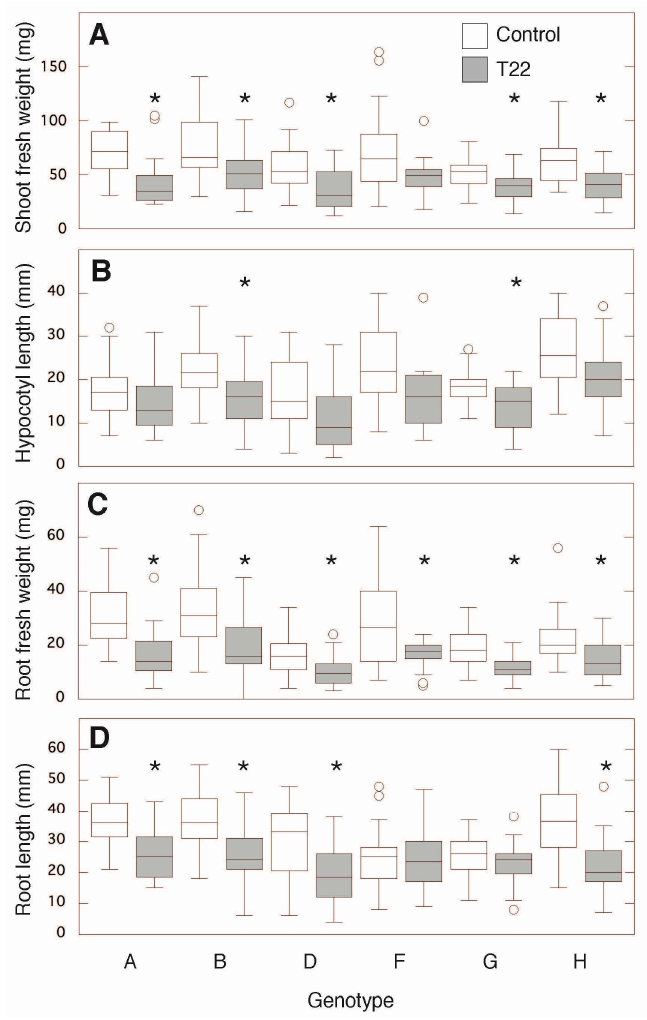
Figure 3. Effects of T22 on sugar beet seedling growth under sterile conditions. Box and whiskers plots show the effects on ( A ) shoot FW, ( B ) hypocotyl length, ( C ) root FW and ( D ) root length by Trichoderma afroharzianum T22 on six genotypes of sugar beet seedlings 9 days after T22 application. Sugar beet seedlings treated with T22 and the water control are represented by filled and open boxes, respectively, and n is 18–24 seedlings. Significant differences between T22 and the corresponding control are denoted with asterisks , outliers are depicted as circles.